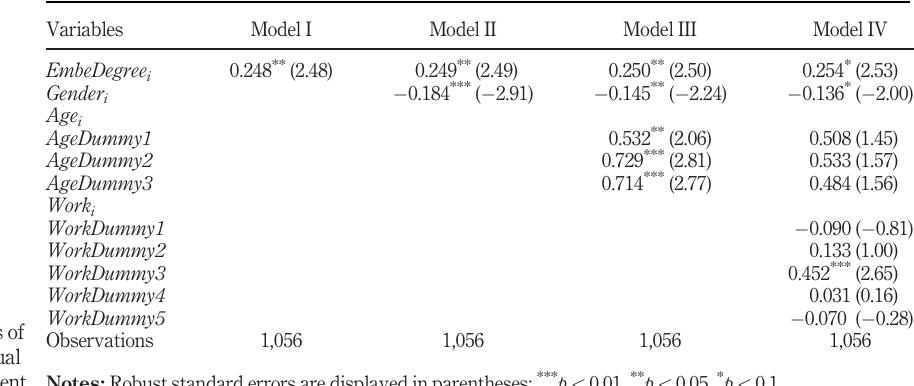
Table 5. Regression results of the whole individual perception of